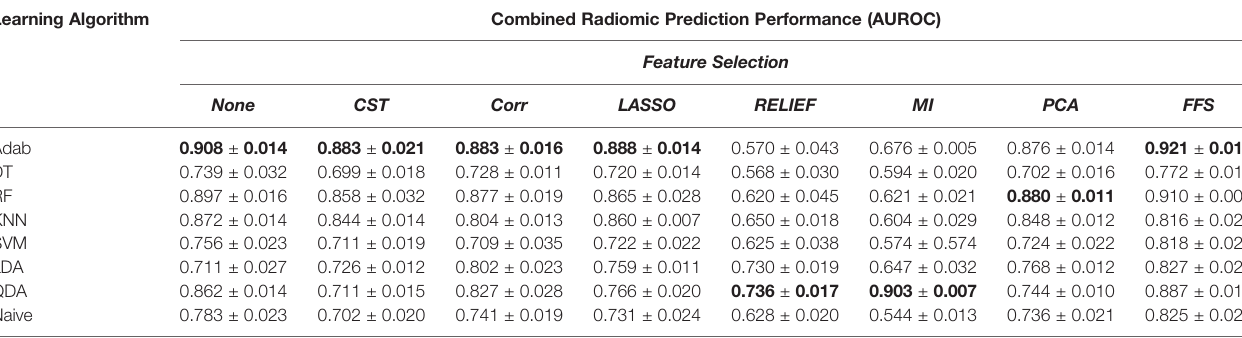
TABLE 3 | The prediction power of the joint context and target radiomic with different learning algorithms and feature selection methods over the balanced dataset. Learning Algorithm Combined Radiomic Prediction Performance